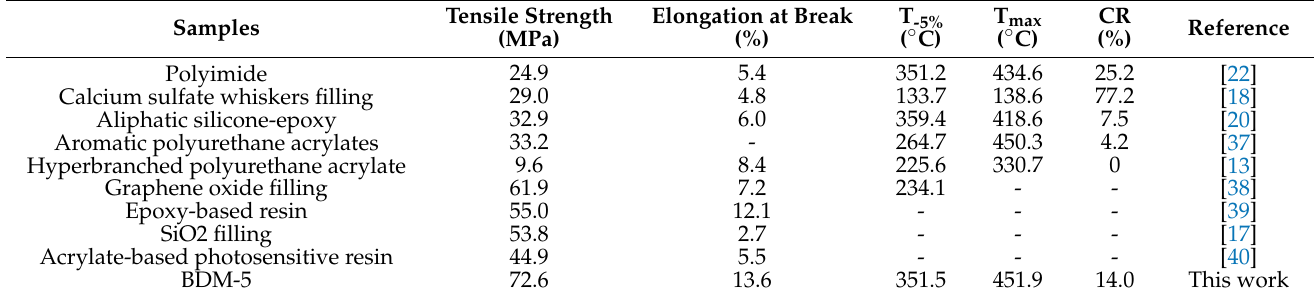
Table 6. Comparison of mechanical and thermal properties of 3D-printed samples based on different photosensitive inks. Samples